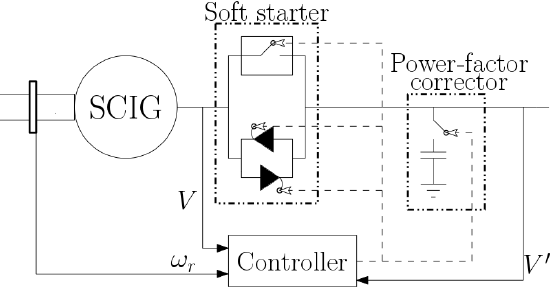
Figure 21. Control system of a squirrel-cage induction generator (SCIG), adapted from [116].